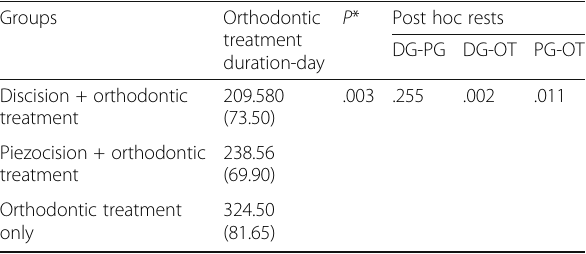
Table 6 Comparison of orthodontic treatment duration among the